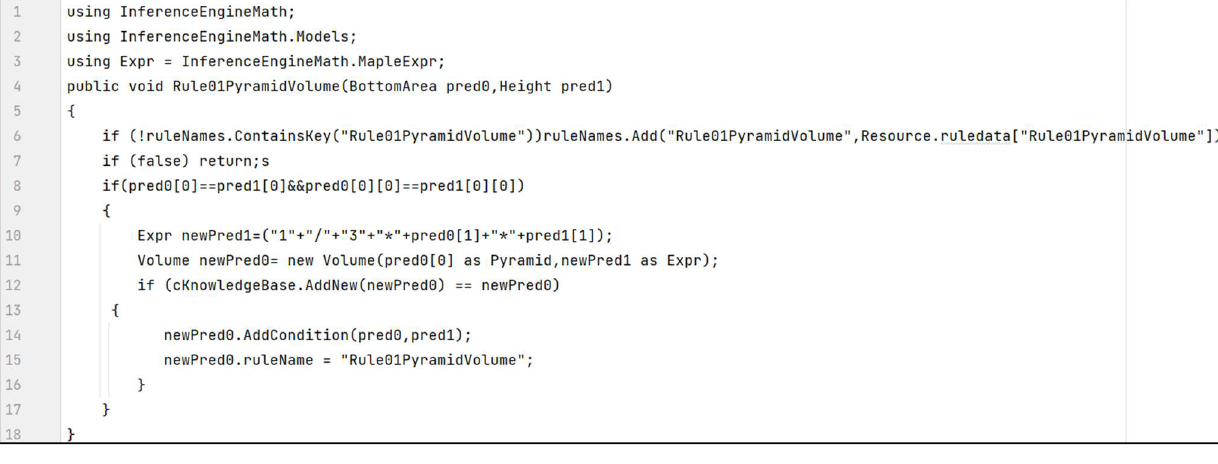
Figure 6. Executable rule code.